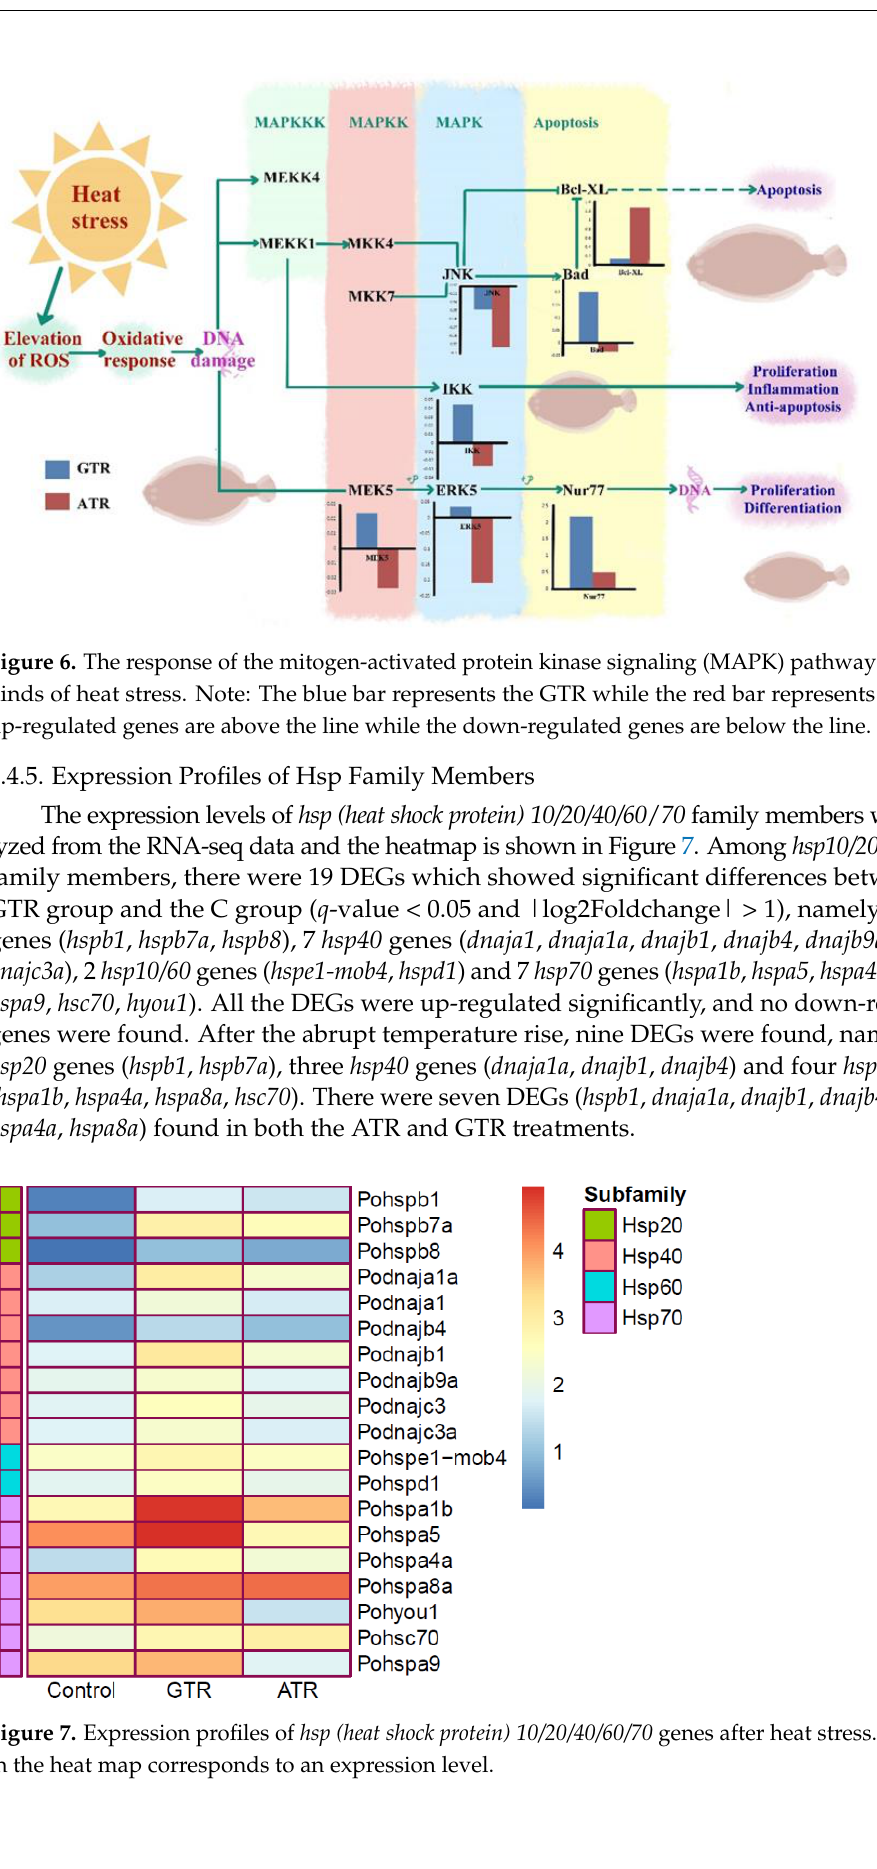
Figure 7. Expression profiles of hsp (heat shock protein) 10/20/40/60/70 genes after heat stress. Each cell in the heat map corresponds to an expression level.